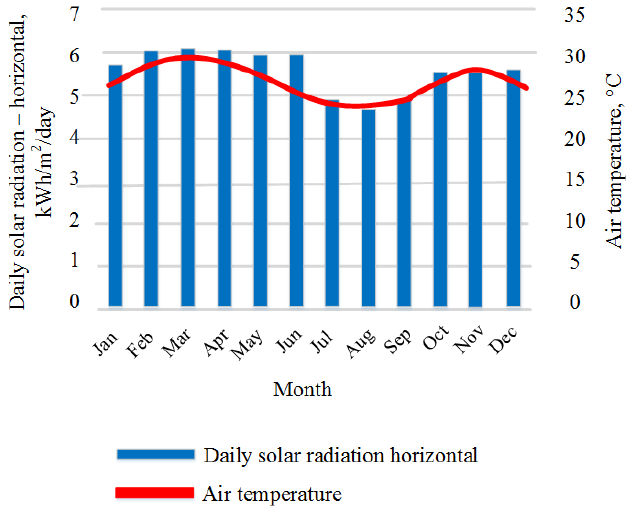
Fig. 2. Monthly average climatic data for the selected site (obtained from RETScreen, NASA